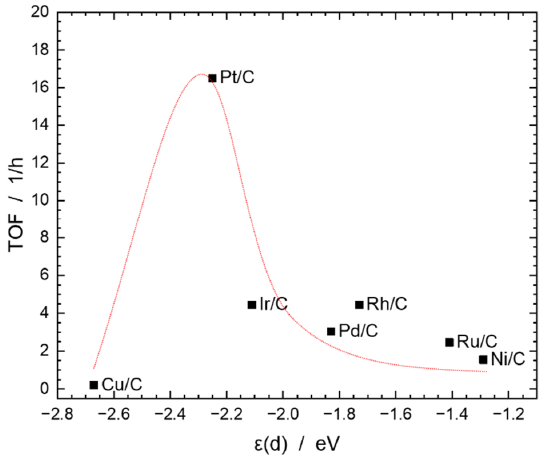
Figure 10. Resulting volcano plot for the TOF of the transition metal catalysts in the β -methylation of 2-phenyletahanol. T = 120 °C, 1.5 equiv. NaOH, and t(Reaction) = 24 h. The red curve was drawn for the purpose of clarity.